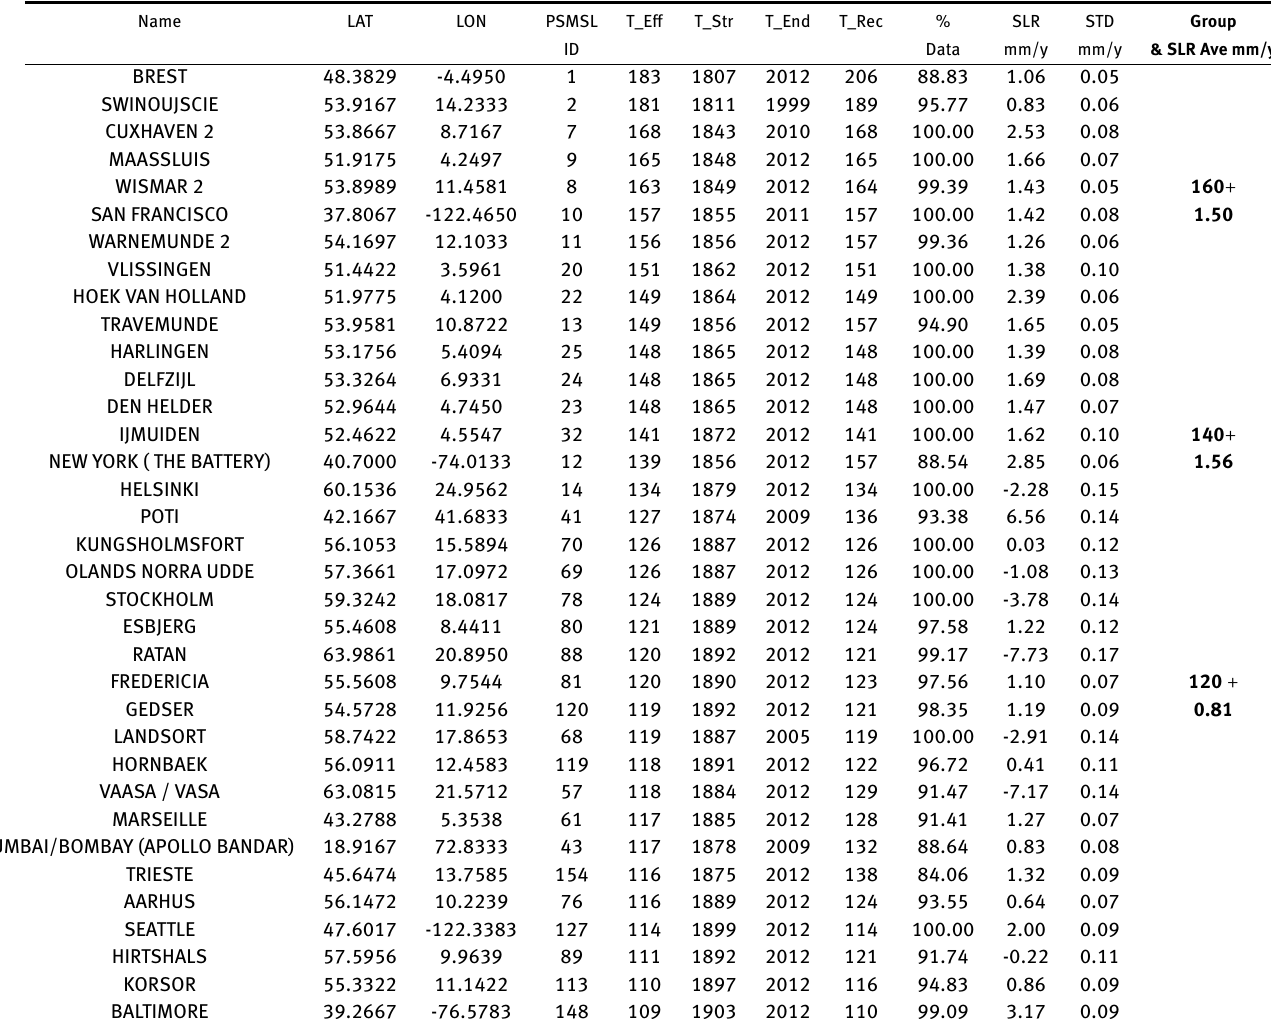
Table 1: Tide gauges of PSMSL. Records not satisfying the minimum 60 years of recorded data necessary to compute a reliable relative rate of rise of sea levels are also included. The PSMSL data are proposed as: station name; latitude and longitude of the station; PSMSL station code; T_Eff Number of years of data used to compute the trend, years; T_Str, T_End range of years used; T_Rec length of the time series, years; SLR and STD Trend and standard error in mm/year. Source http://www.psmsl.org/products/trends/trends.txt, Table of Relative Mean Sea Level Secular Trends derived from PSMSL RLR Data Last update